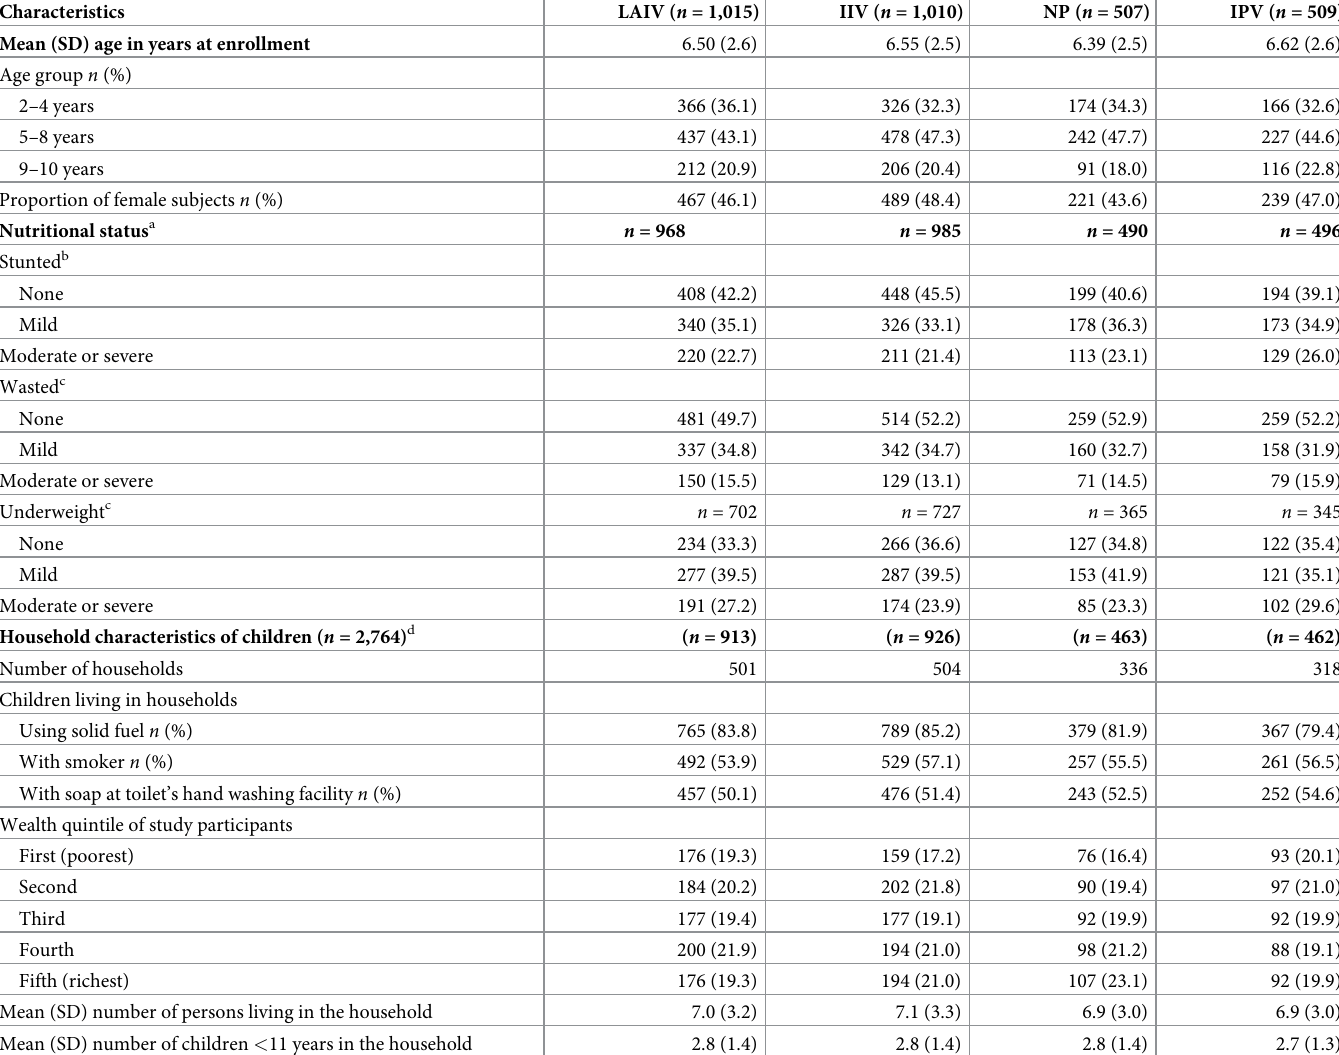
Table 1. Baseline demographic characteristics of study participants by vaccination